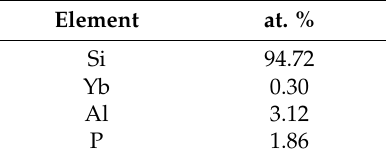
Table 1. Element doping ratio in atomic percentage [7].